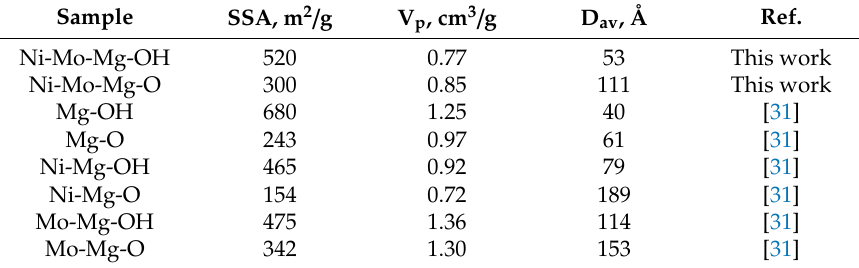
Table 1. Textural properties of the prepared and previously reported